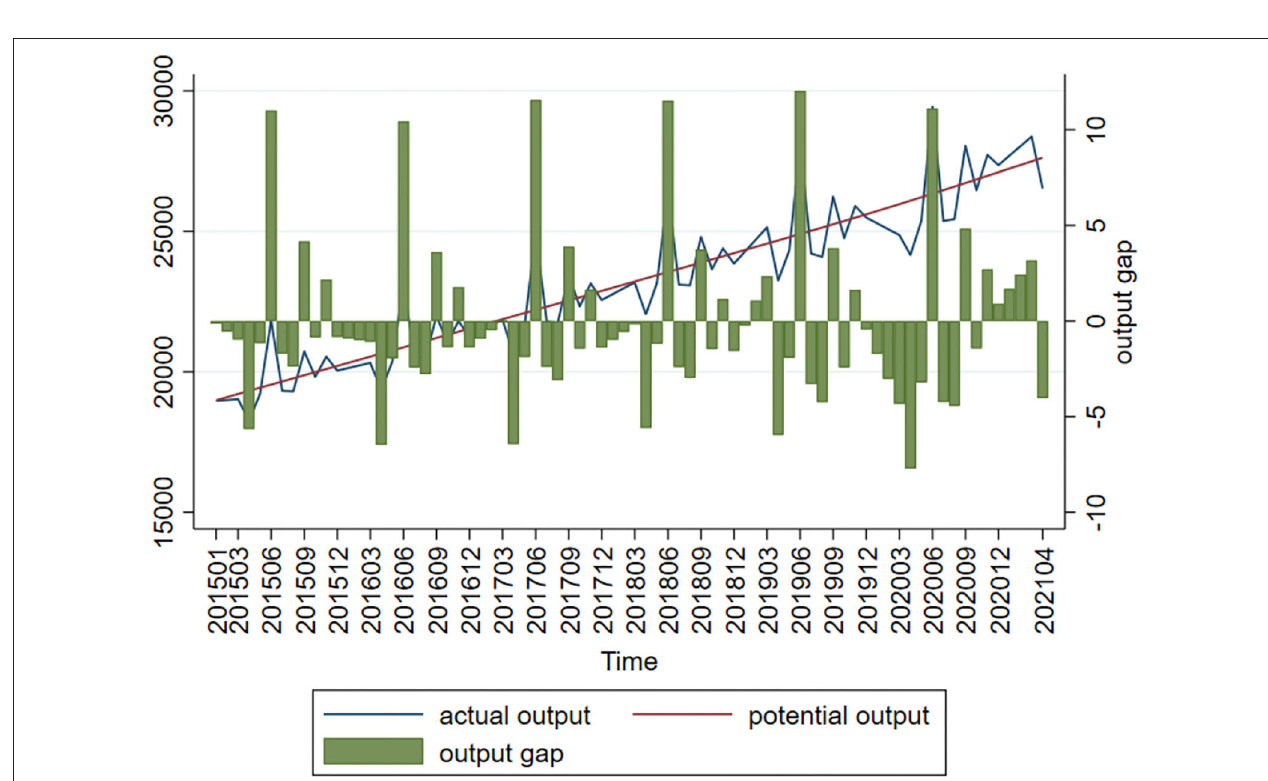
FIGURE 4 | Output gap